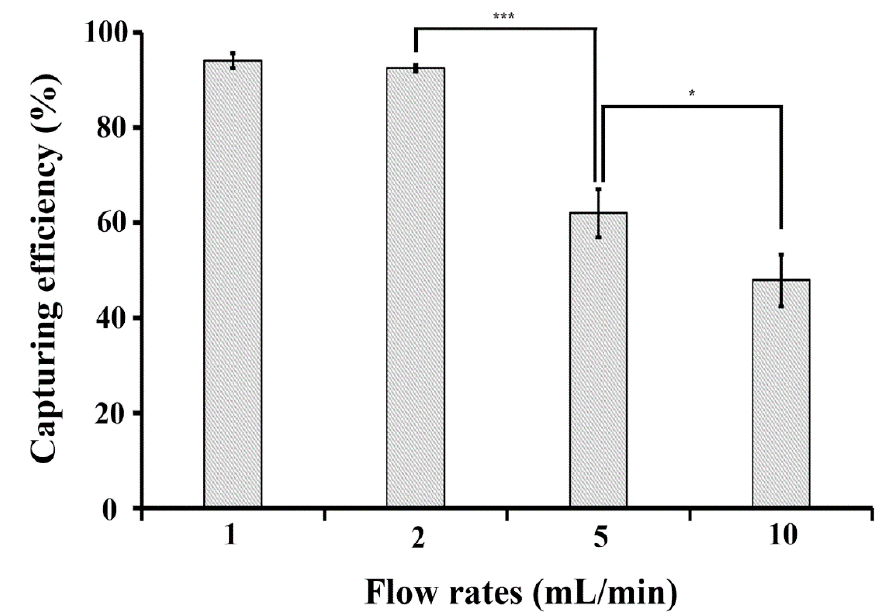
Figure 2. Effect of flow rate on bacteria capturing efficiency in 3DpmFD. Ten millilitres (10 mL) of PBS containing E. coli O157:H7 (10 4 CFU/mL) and Ab-MNPs (10 13 particles/mL) were injected into 3DpmFD at different flow rates (1–10 mL/min). *: p < 0.05, ***: p < 0.001. Student t -test. Sample number = 3.